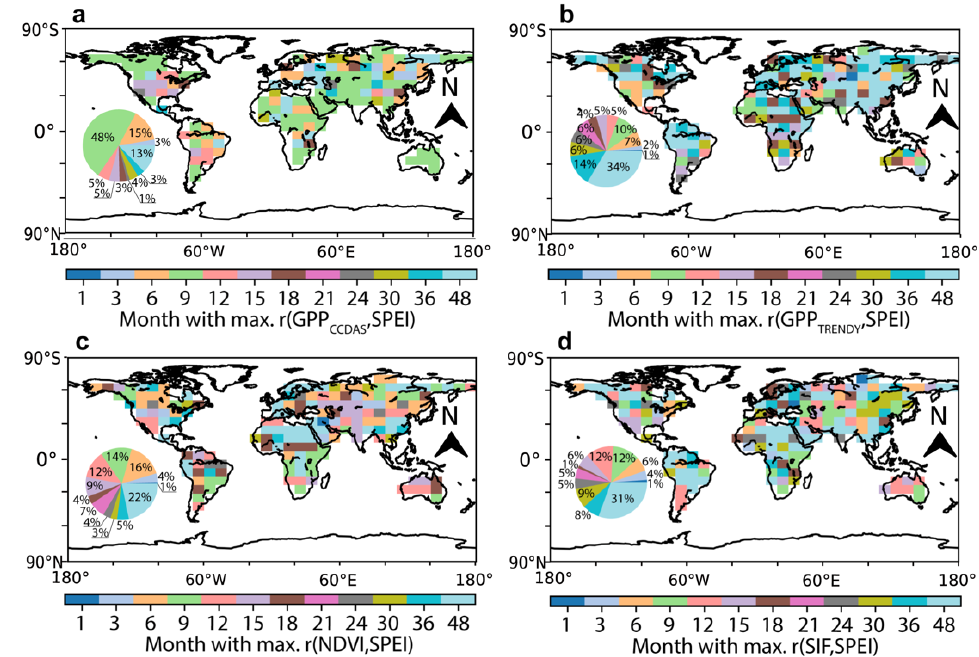
Figure 5. Drought duration identification using the correlation between GPP, NDVI, SIF, and SPEI. a, the optimal drought duration (month) that is best identified (with the tightest correlation among 12 durations) with respect to the Pearson correlations between SPEI from different durations and the GPP from CCDAS. The inset denotes the percentage for each drought duration. ( b ), same as ( a ), but for TRENDY multi-model mean (S3, 6 models) GPP. ( c ), same as ( a ), but for the NDVI from GIMMS3g. ( d ), same as ( a ), but for SIF from